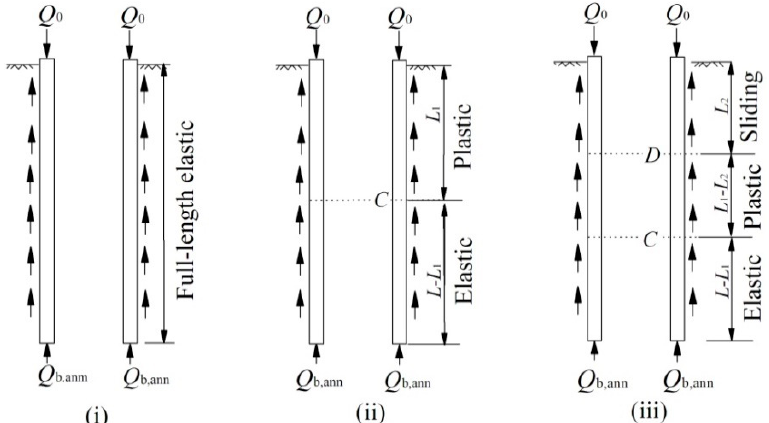
Figure 5. Calculation model for surrounding soil. (( i ) elastic stage, ( ii ) plastic stage, ( iii ) sliding stage). (1) All surrounding soil in the elastic load transfer